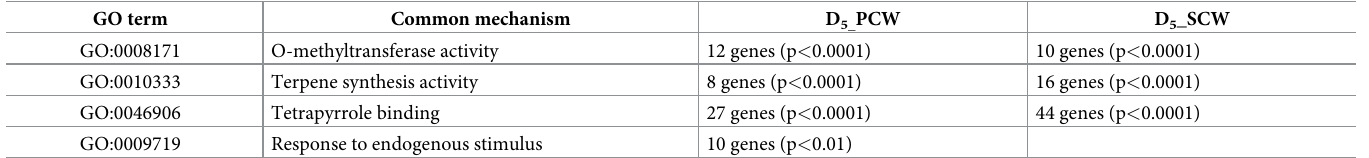
Table 3. GO enrichment analyses of specifically expressed genes in PCW or SCW stage of developing G . raimondii (D 5 ) fibers. List and annotation of genes are described in S3 Table. GO